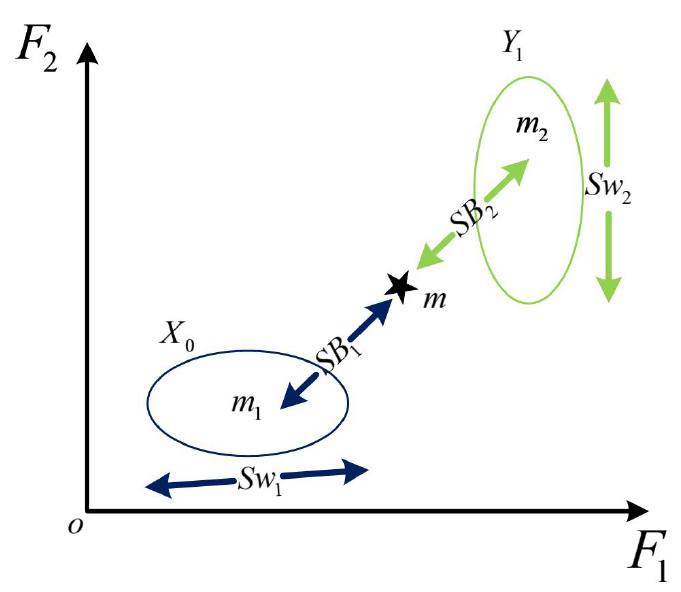
Figure 5. Schematic diagram of the two types of models.